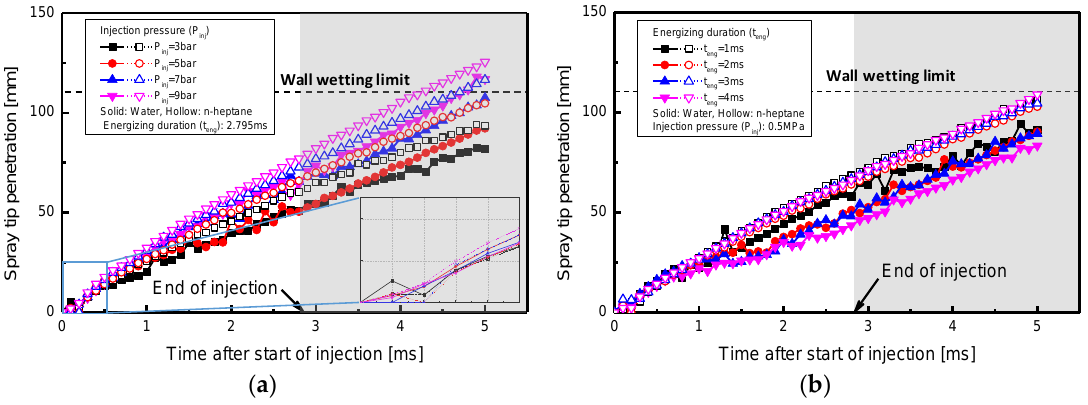
Figure 6. Spray tip penetration characteristics for ( a ) injection pressure and ( b ) energizing duration.